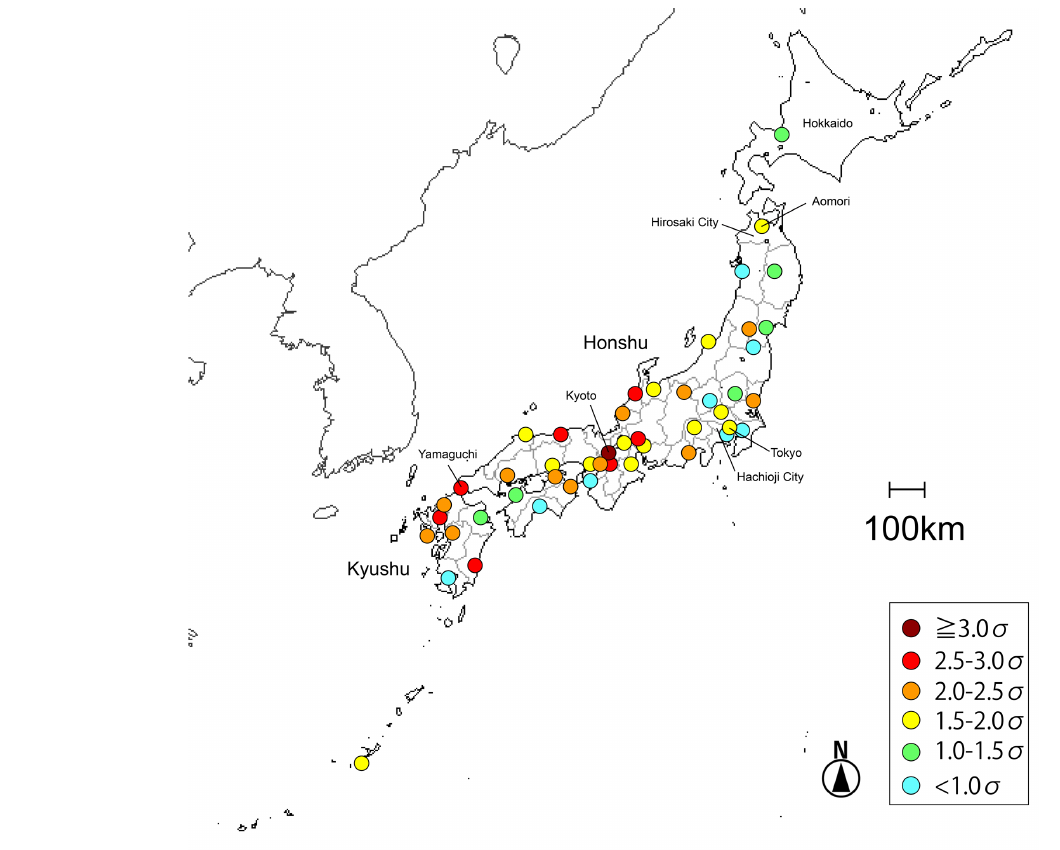
Figure 2. Significance level of the solar rotational period detected in the summertime thunder/lightning data for the periods of solar cycle maxima during the period of AD